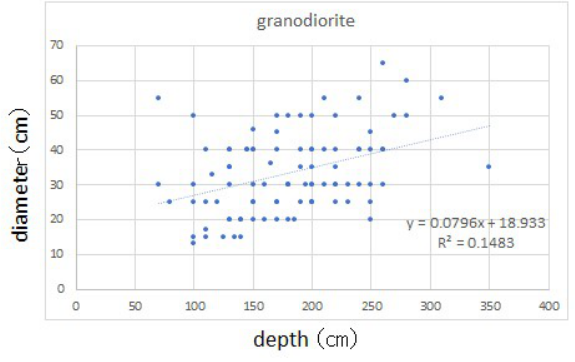
Figure 3 . Relationship between diameter and depth in granodiorite area